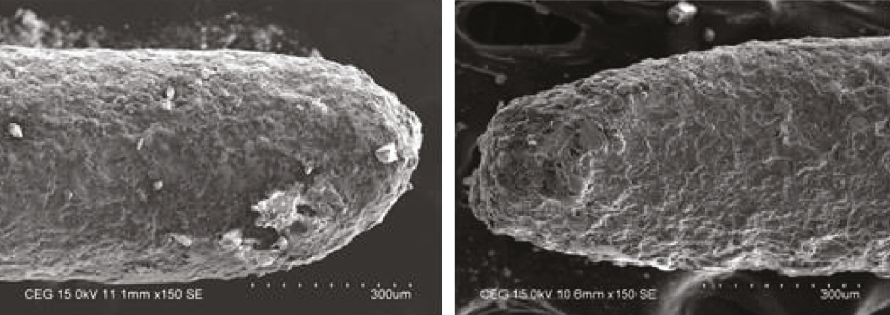
Figure 9: Uncoated (parabola section) and coated tools (elliptical section) were used for Al–Zn–Mg/Si